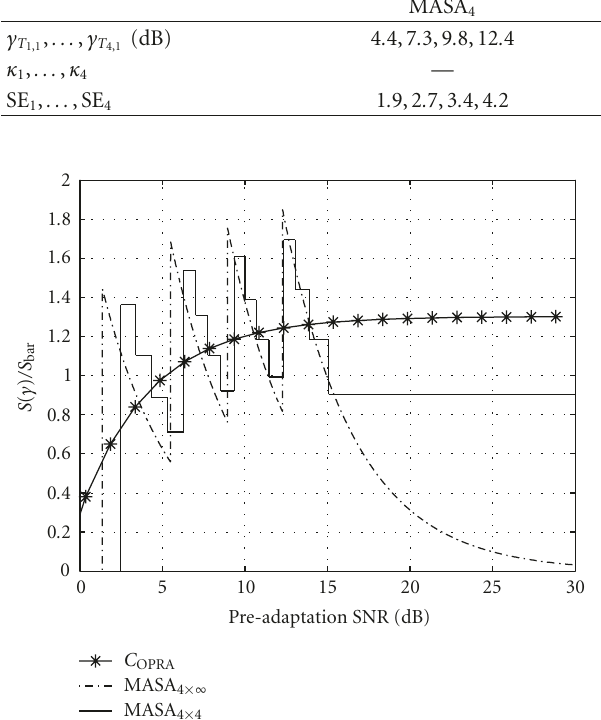
Figure 4: Power adaptation schemes for MASA 4 ×∞ and MASA 4 × 4 as a function of preadaptation SNR, plotted for an average preadapta- tion SNR γ = 10dB. Optimal power adaptation for continuous-rate adaptation C OPRA as